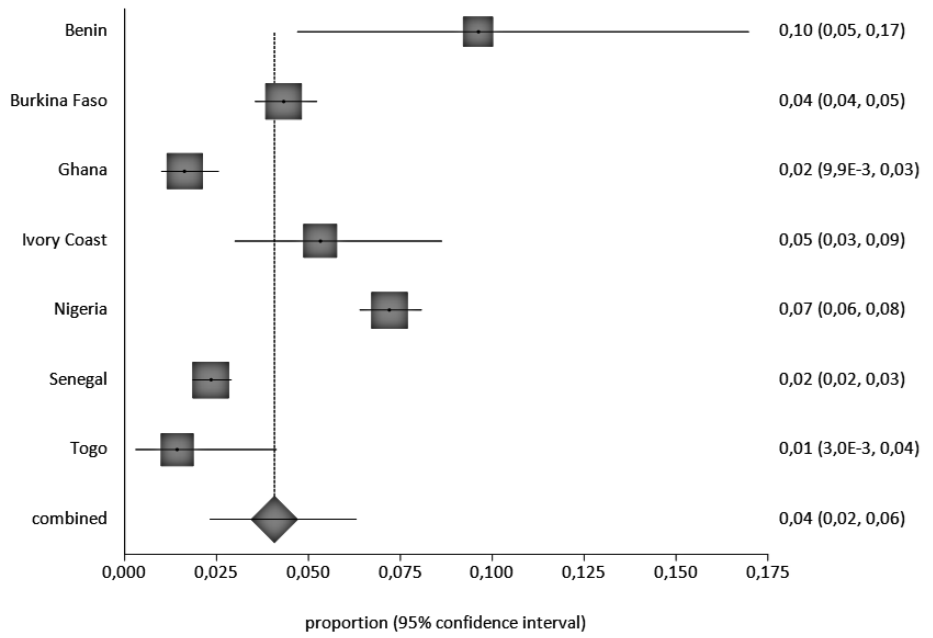
Figure 2. Overall HBV Prevalence in Children, 0–16 Years Old, in West Africa, Pooled by Country. A black square represents the HBV prevalence in the forest plot. The square position represents the prevalence.